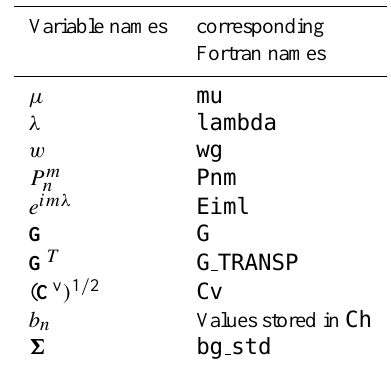
Table A2. List of precalculated variables and their Fortran